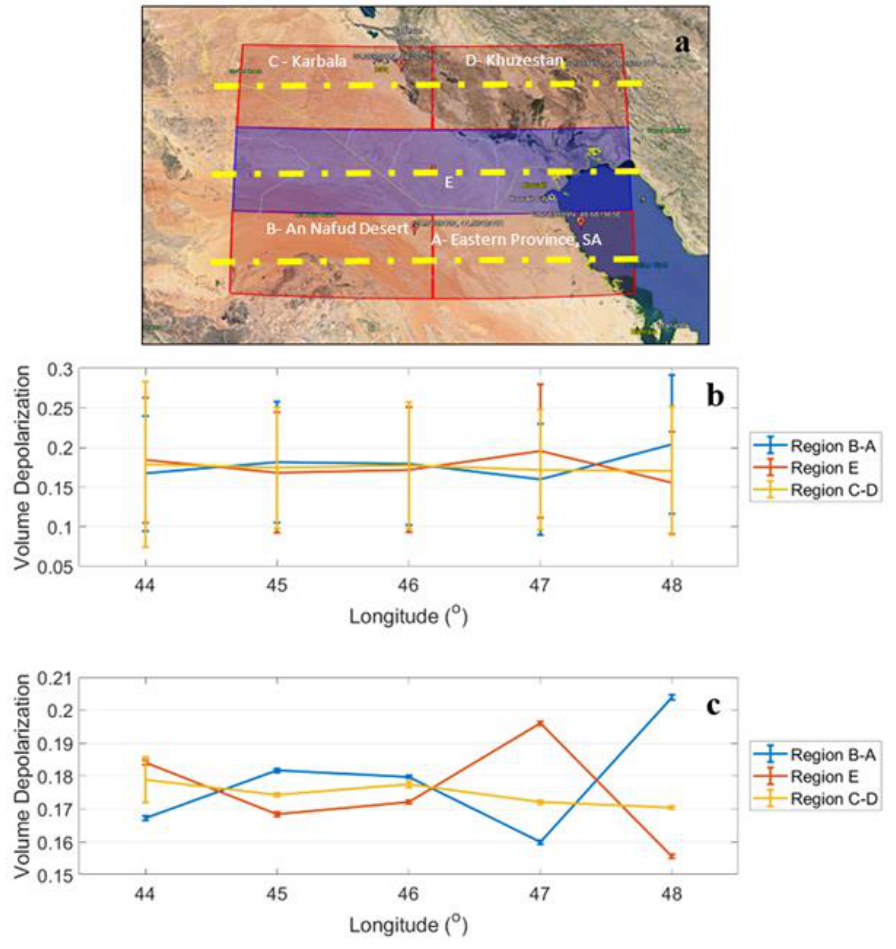
Figure 6. The mean volume depolarization for all dust layers detected below 8 km ( a ) from June 2006 to April 2019, night and day for the indicated regions ( b , c ).